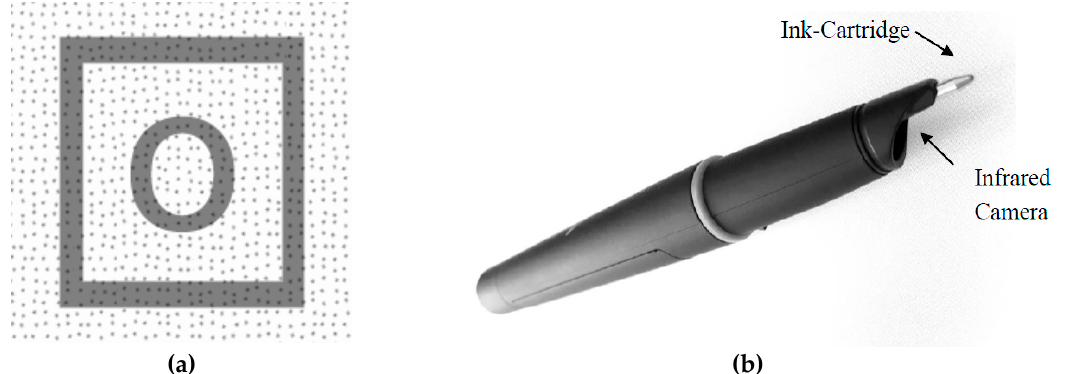
Figure 2. The dot pattern behind this magnified printed rectangle and letter “o” ( a ) is used by the infrared camera built in Anoto Digital Pens ( b ) to uniquely identify its location.